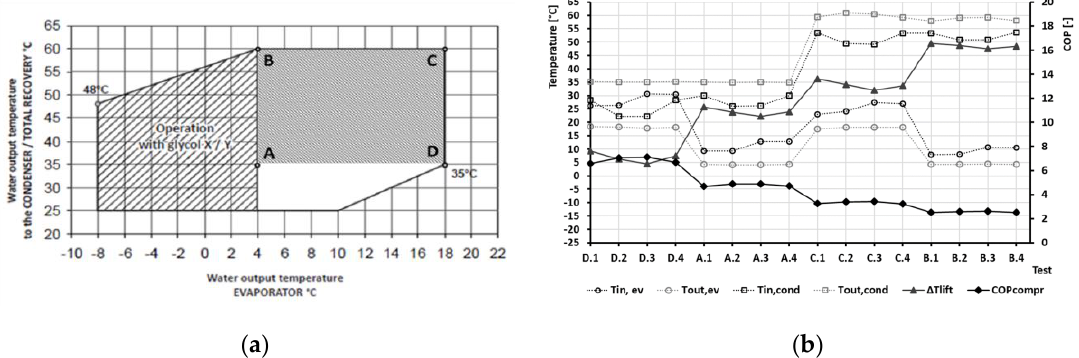
Figure 6. Limits of the WSHP operating condition investigated ( a ) and results of the laboratory stress tests ( b ). COP: coefficient of performance.